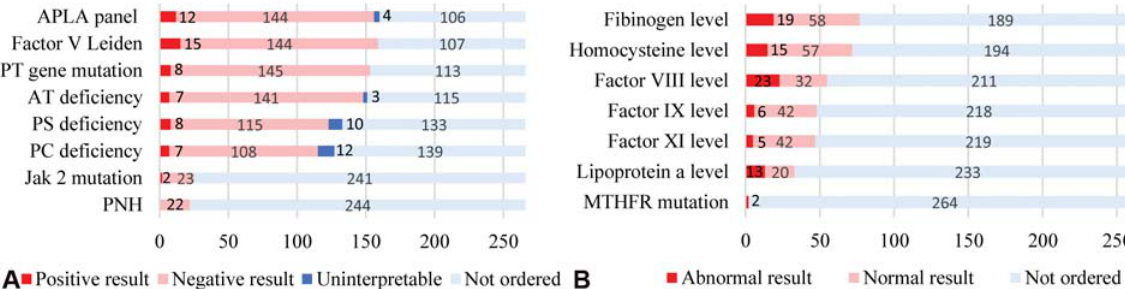
Fig. 2 Results of thrombophilia workup in all patients ( N ). ( A ) Thrombophilias with reasonably well-de fi ned role in pathogenesis of venous thromboembolism (VTE) based on contemporary knowledge. Uninterpretable APLA testing indicates abnormal APLA panels that were not repeated. Uninterpretable AT, PS, and PC tests include tests that were performed under conditions that jeopardized accurate interpretation of results such as acute thrombosis or ongoing anticoagulation. ( B ) Other thrombophilias. APLA, antiphospholipid antibody; AT, antithrombin. MTHFR, methylenetetrahydrofolate reductase; PC, protein C; PNH, paroxysmal nocturnal hemoglobinuria; PS, protein S; PT,